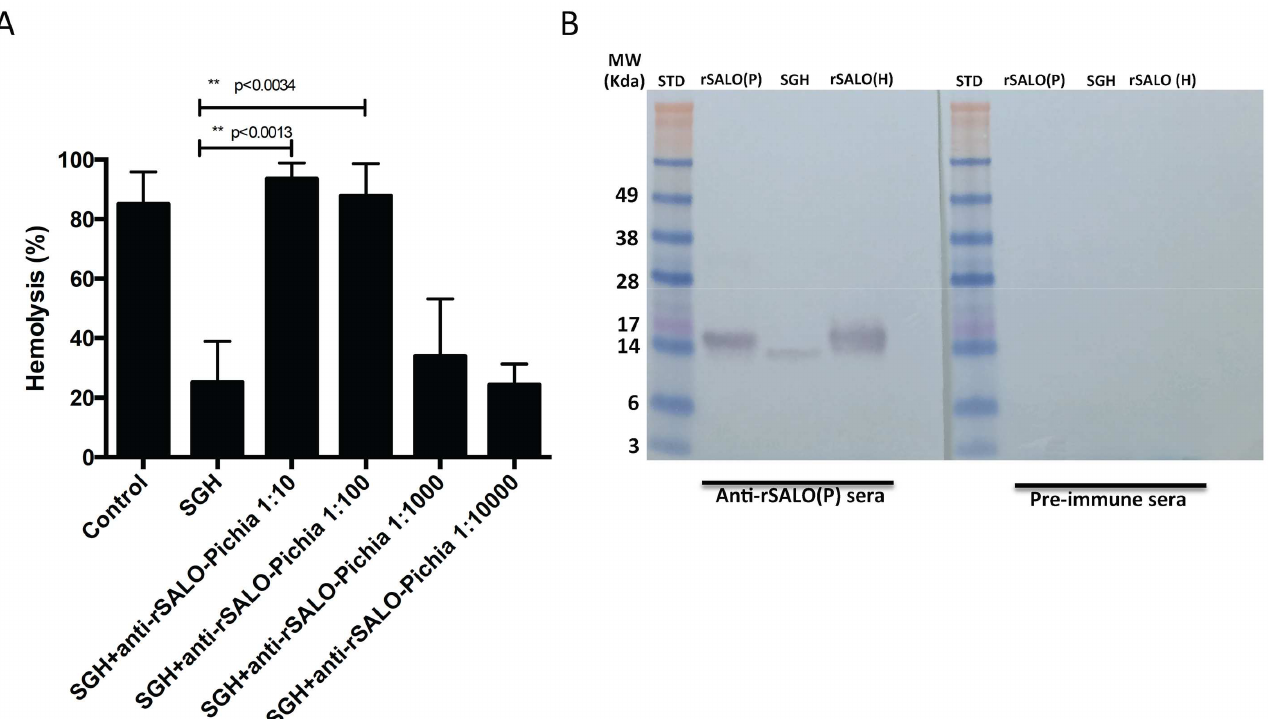
Fig 2. Antibodies against rSALO(P) block anti-complement activity present in the salivaryglands of the sand fly Lutzomyia longipalpis (SGH). (A) Hemolytic assays using SGH (0.5 salivary gland pairs) in the presenceof different dilutions of anti-rSALO(P) antibodies(1:10; 1:100; 1:1000or 1:10000, in PBS). The data represents the mean ± standarddeviationof three independentrepetitions(ANOVA and Tukey test). Hemolysis was measured at 414nm. (B) Western blot showingrSALO(P) antibodiesrecognizing rSALO(P) (rSALO Pichia), native SALO from the salivary gland homogenate of Lutzomyia longipalpis (SGH), and rSALO(H) (rSALO HEK). SDS-PAGE was run under reducing conditions. Pre- immune sera was used as a control.